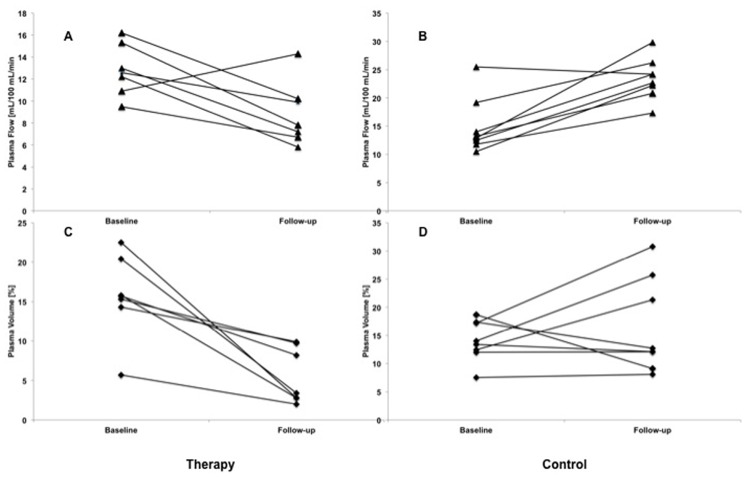
Development of individual values for plasma flow and plasma volume in therapy and control group.Plasma Flow (Fp) and Plasma Volume (Vp) at baseline and follow-up are displayed at the y-axis. Note the unidirectional development of Fp in both groups (A, B) and of Vp in the therapy group (C). However, in one animal from the control group, we observed a decline in Vp, which can be attributed to fast tumor growth and a high level of necrosis in the tumor (D).